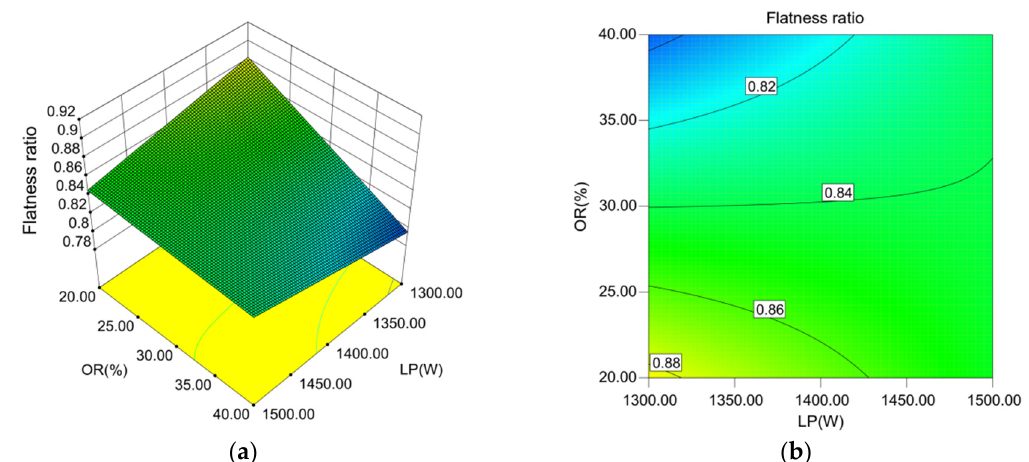
Figure 5. ( a ) Response surface of laser power and overlap ratio interaction affecting the flatness ratio; ( b ) Contour line of the response surface. Metals 2020 , 10 , x FOR PEER REVIEW